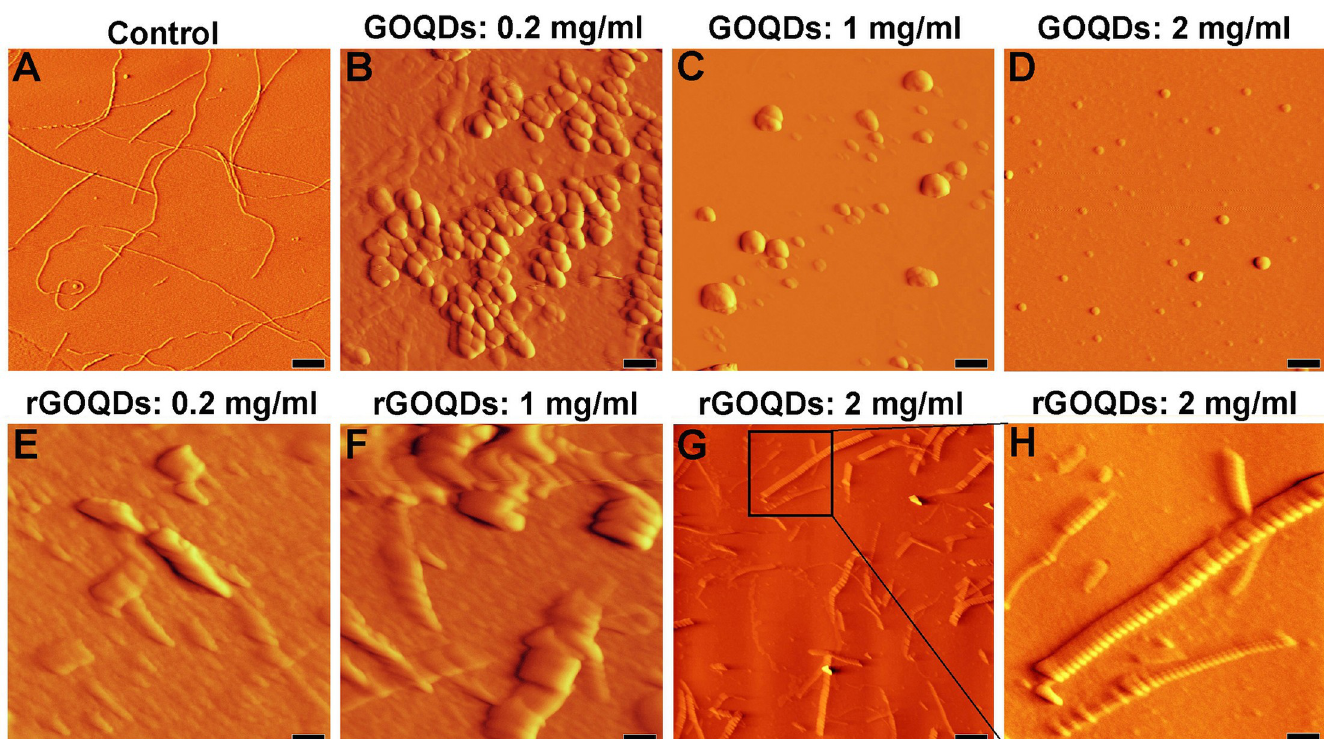
Fig 8. AFM images of HEWL incubated with different concentrations of GOQDs or rGOQDs. Protein samples (50 μ M) were incubated in 50 mM glycine (pH 2.2) at 57 � C either alone or with different concentrations of GOQDs, or rGOQDs. (H) An enlarged view of (G). The scale bar is 2000 nm in (G) and 500 nm in the other